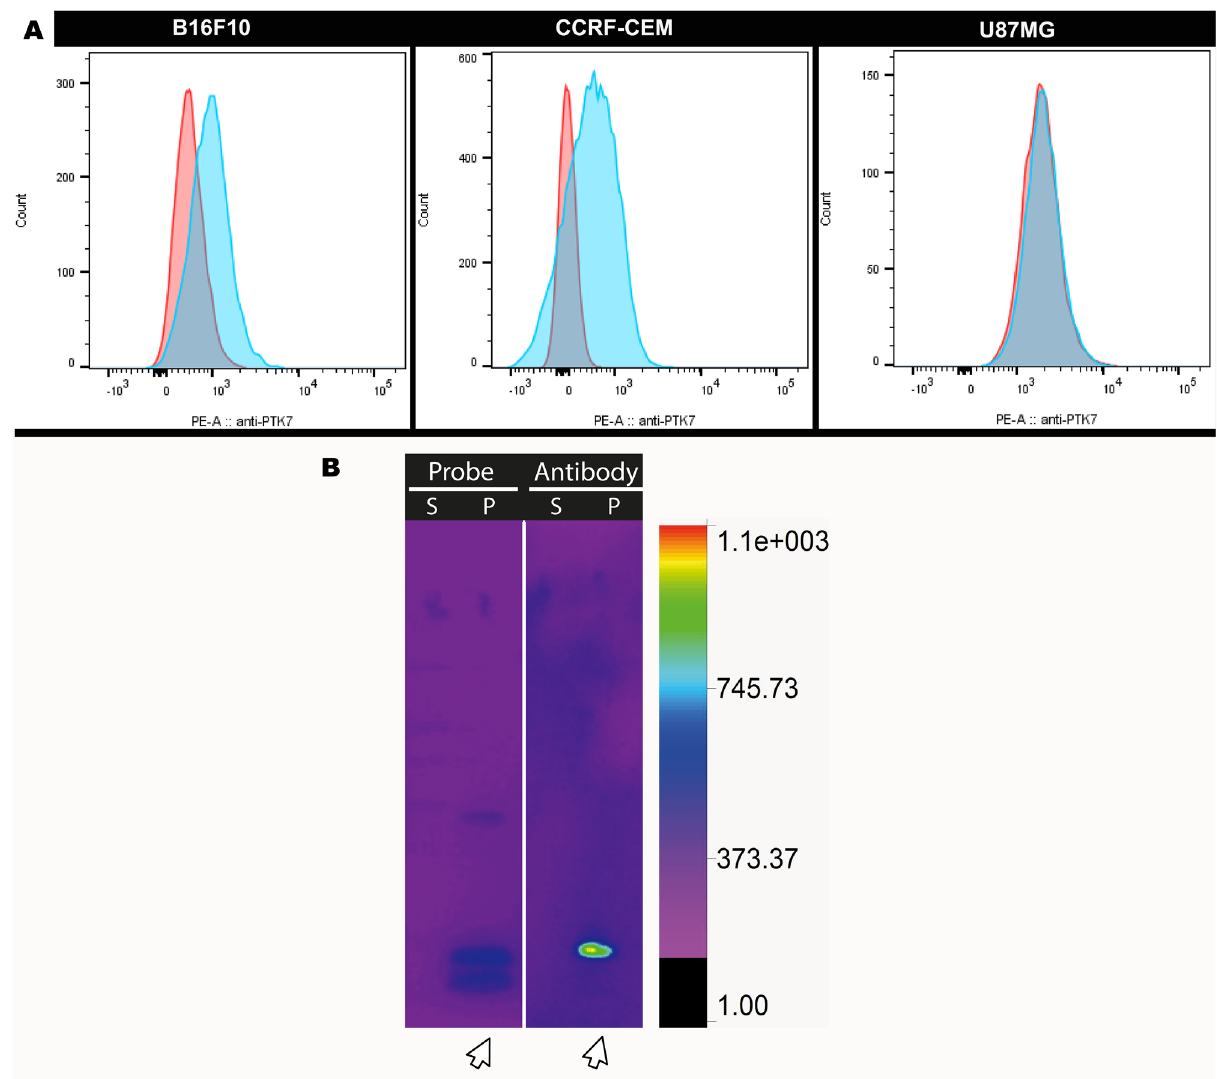
Figure 1. ( A ) Flow cytometry with cell lines B16F10, CCRF-CEM and U87MG. Histograms of cell lines after for incubation with anti-PTK7-PE antibody (in blue) and control (in red). ( B ) Grouping of Western blot cropped of proteins extracted from the supernatant (S) and pellet (P) of B16F10 cells culture. Incubation was performed with the Sgc8-c-Alexa647 probe (Probe) and with the anti-PTK7-PE antibody (Antibody). Arrow indicates the presence of PTK7 only in the cell pellet. White dividing line indicates different gels (performed in parallel) and exposures (full-length gels are shown in Fig. S1 in Supporting